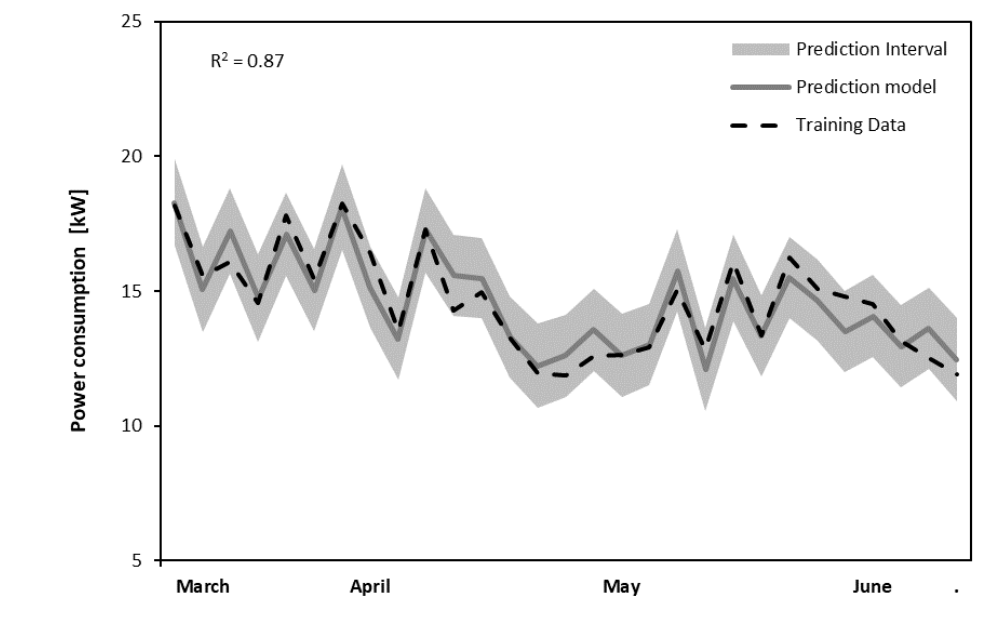
Figure 9. The predicted power consumption plotted against the training data and with the corre- sponding prediction